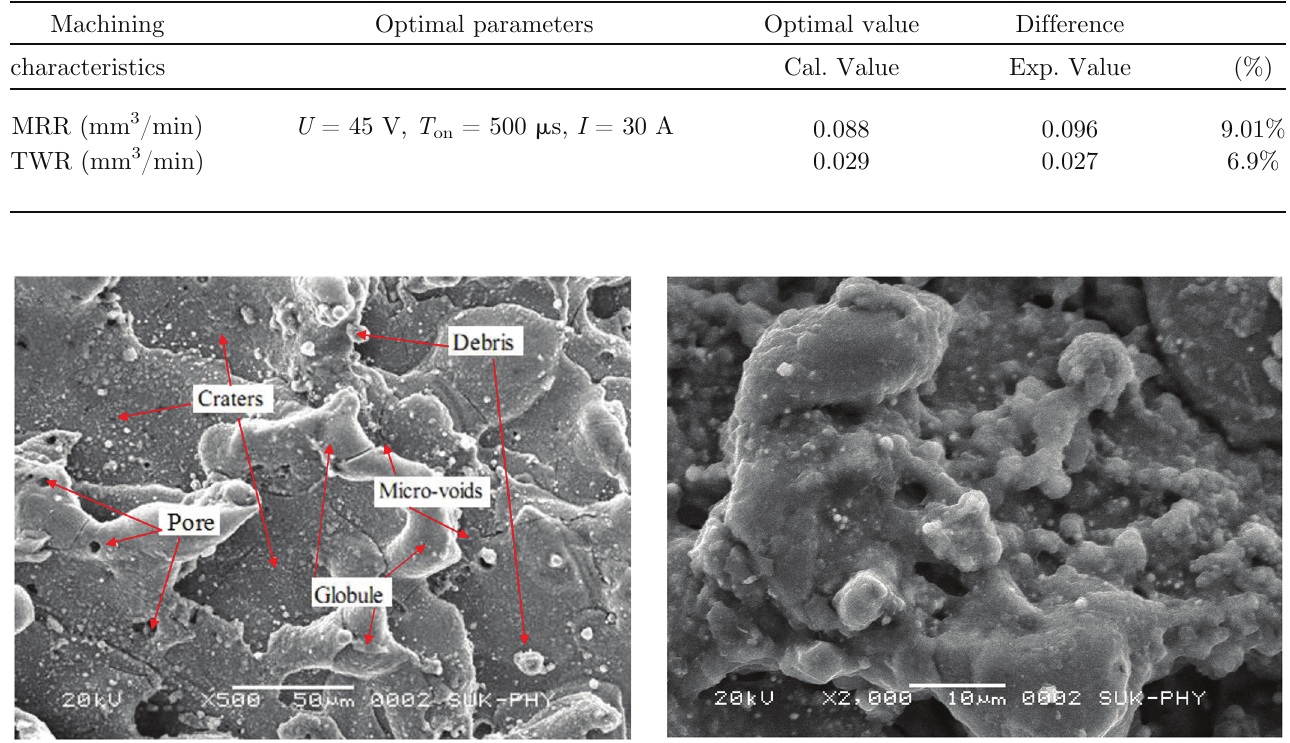
Fig. 8. Chart of main effects for S / N ratios of u j . Table 6. Con fi rmation of experimental results of PSI method.